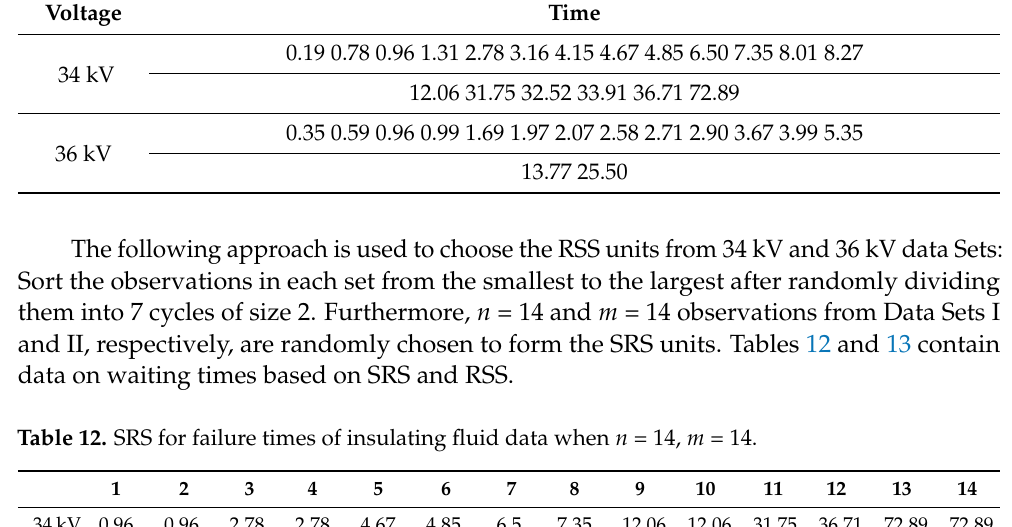
Table 11. Data sets of insulating fluid breakdown periods between electrodes acquired at various voltages. Voltage